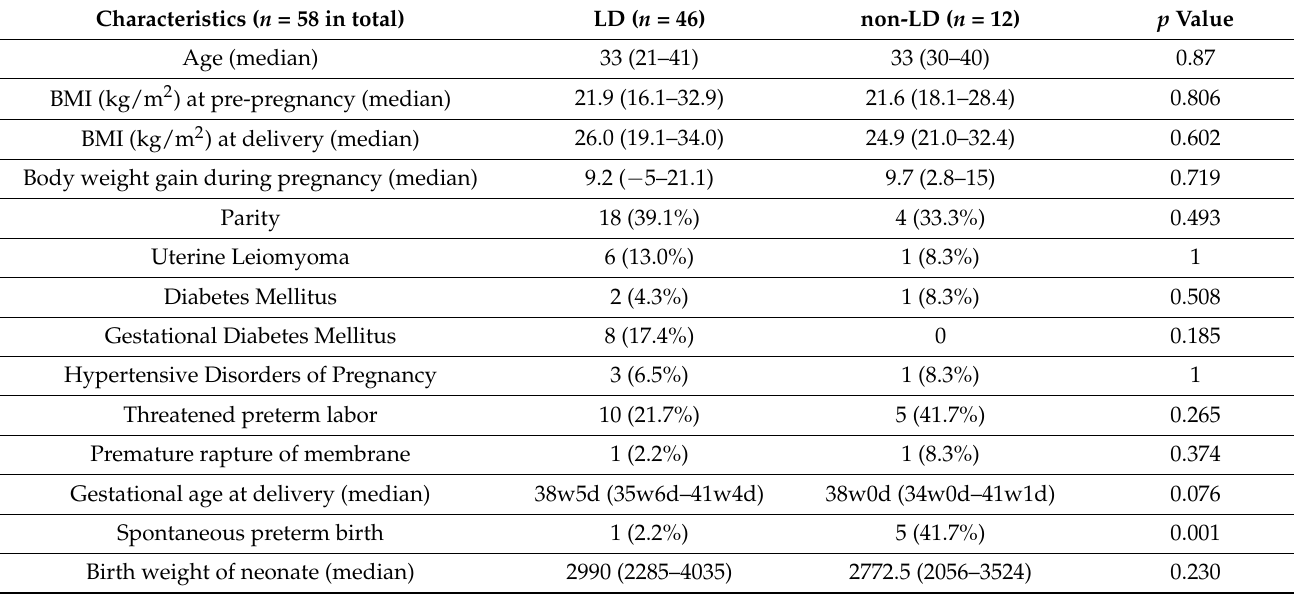
Table 1. Clinical characteristics of LD and non-LD group patients. The clinical characteristics of LD ( n = 46) and non- LD ( n = 12) group patients. Mann–Whitney U test was performed for continuous variables, and Fisher’s exact test was performed for the others. Threatened preterm labor was defined as hospitalization with the presence of regular uterine contractions or shortened cervical length to less than 25 mm before 37th gestational week. Preterm birth was defined as delivery before 37th gestational week, except for artificial preterm